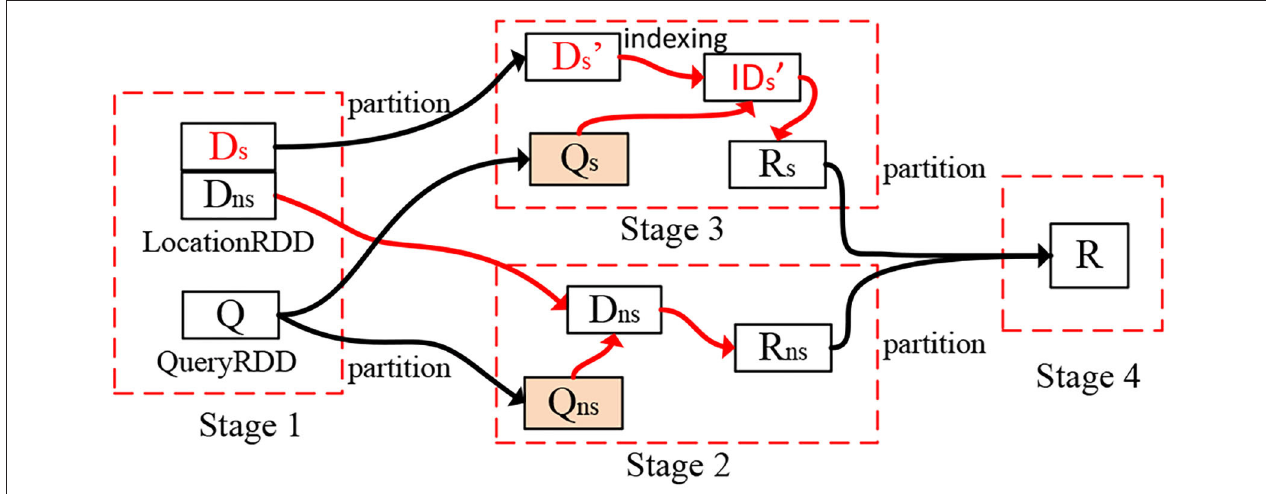
FIGURE 3 | Execution plan for spatial range join. The red lines identify local operations, and black lines show the data partitioning.